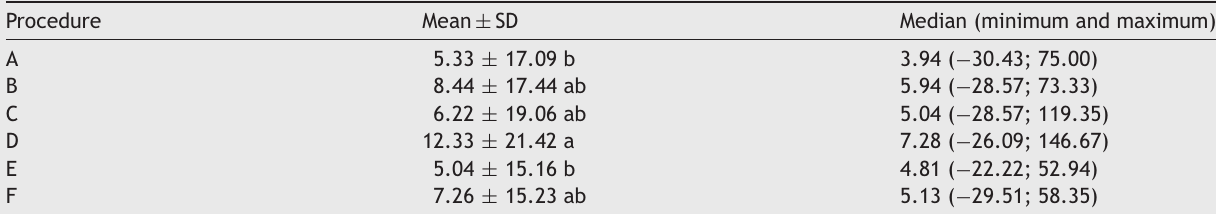
Comparison of all procedures according to the percentage change in pre- and post-procedure nasal inspiratory flow